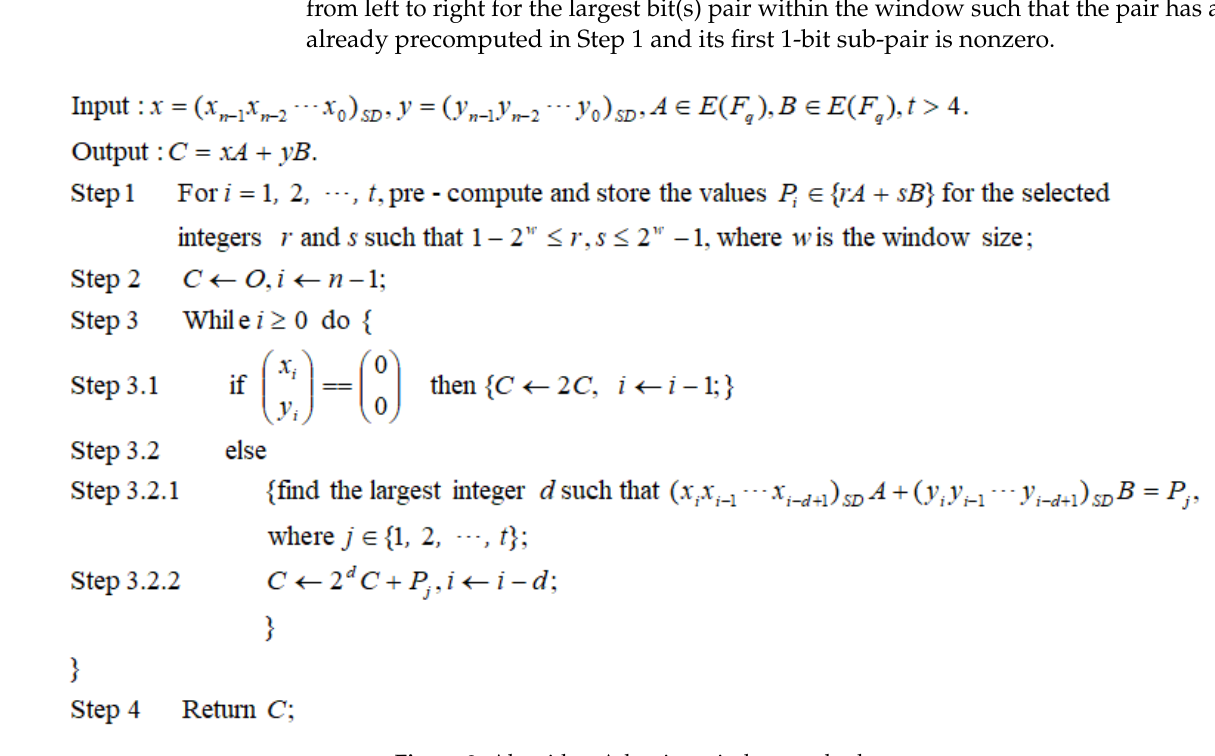
Figure 2. Adaptive window method. Figure 2. Algorithm Adaptive window